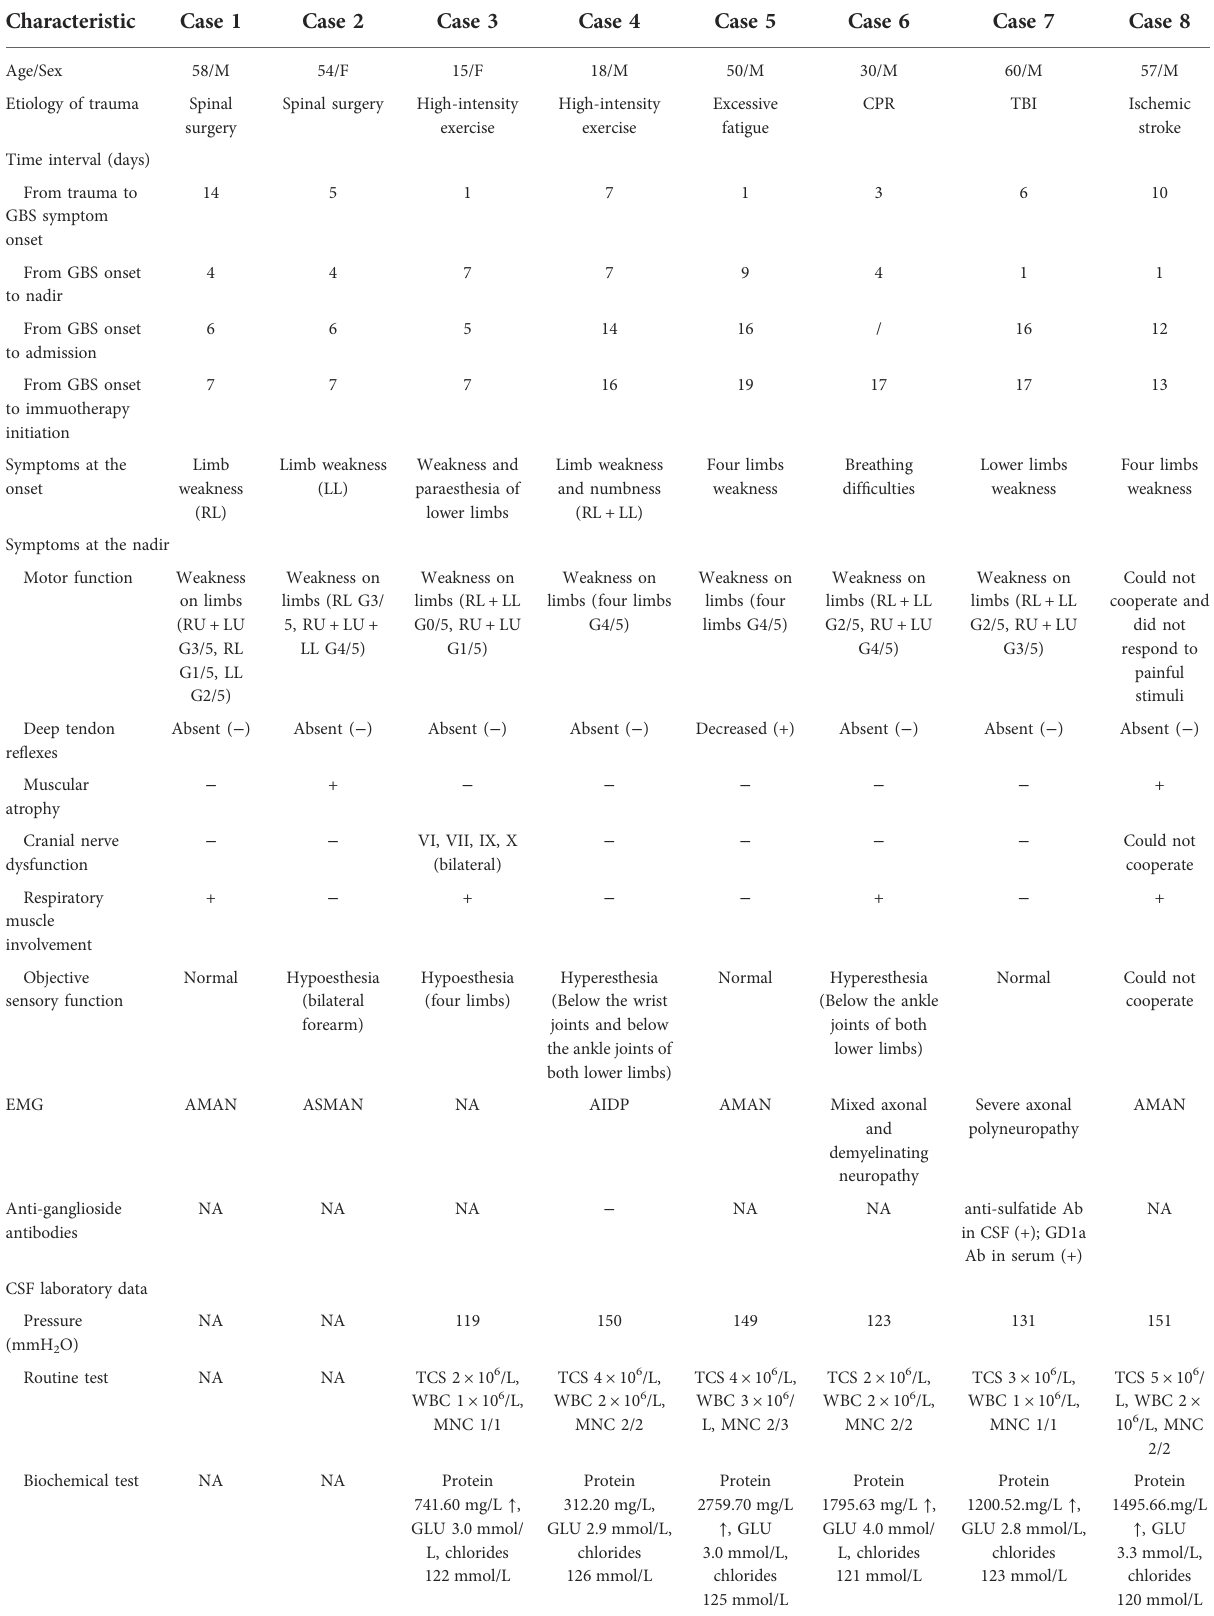
TABLE 1 Clinical manifestations, laboratory data and treatments of eight patients with